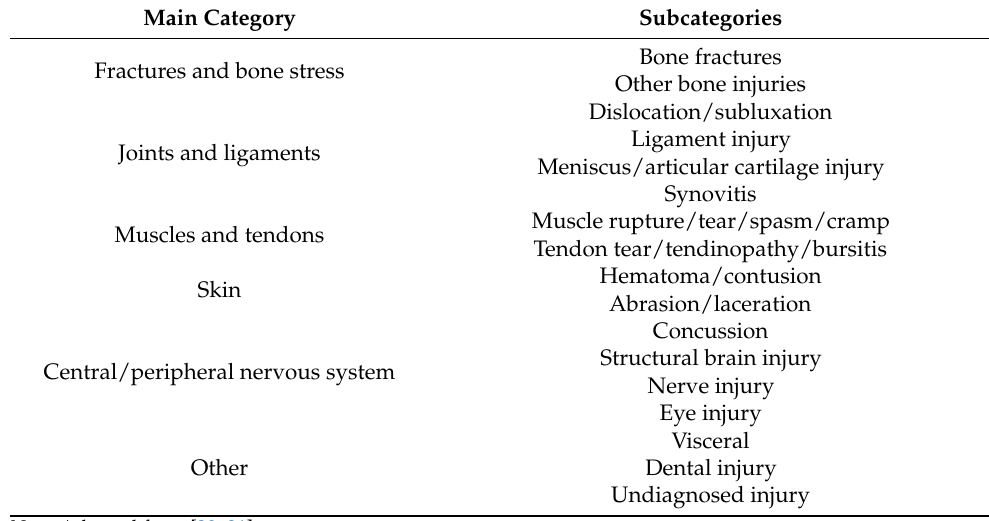
Table 1. Classification according to the type of injury and tissue